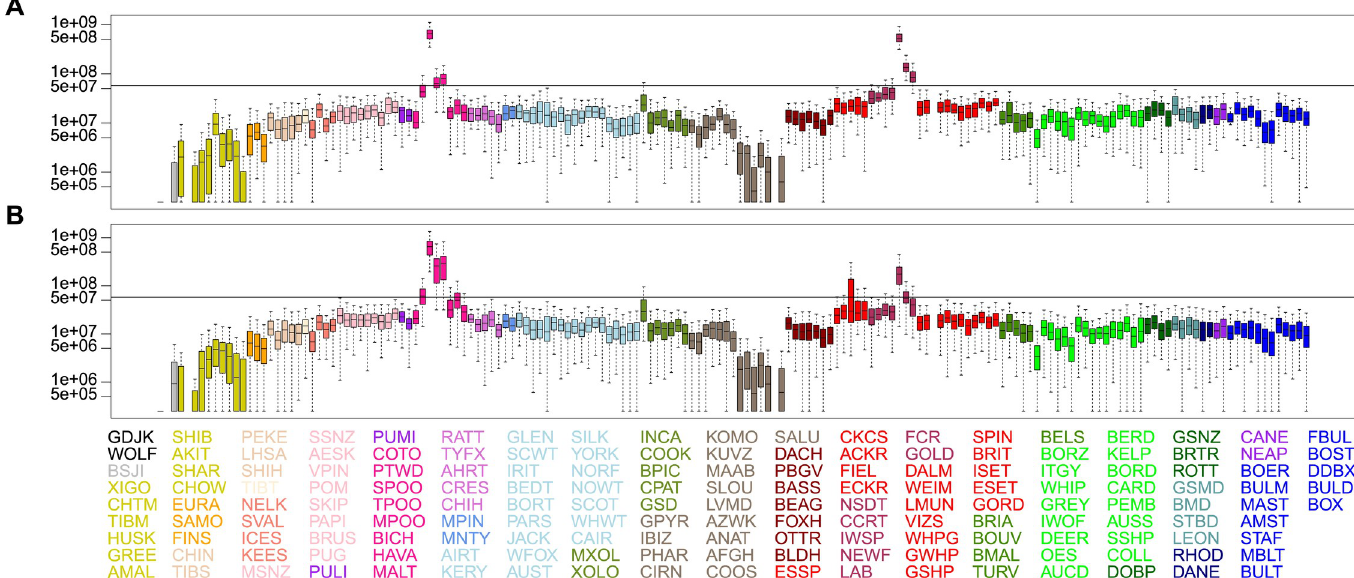
Fig 3. Haplotype sharing analyses of 161 dog breeds including the LBD and ALBD. Haplotype comparison analyses for both LBD (A) and ALBD (B) with 23 domestic dog breed clades, colored separately, are shown. Analysis used a window size of 1900 SNPS with an overlap of 50 SNPs. Breeds are listed and colored on the x-axis. Colors correspond to the 23 previously reported dog breed clades. The y-axis indicates combined haplotype sharing. Breed abbreviations can be found in S2 Table. A significance level of 95% of all across breed sharing is indicated by the horizontal line. Pairs which did not share a haplotype were set at 250,000 bp for graphing.